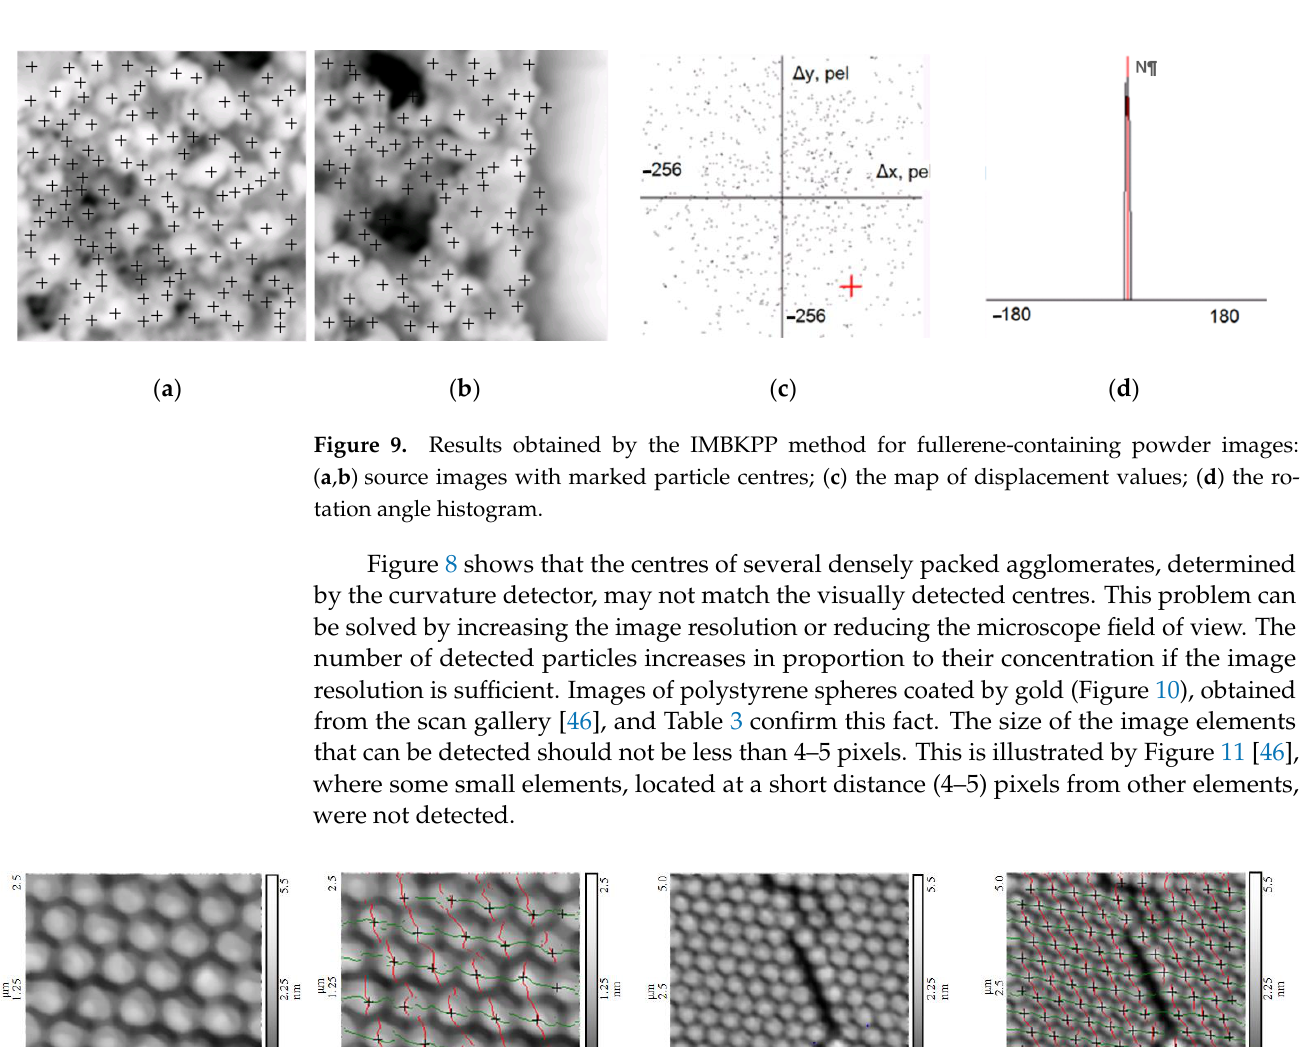
Figure 8. Results obtained by the IMBKPP method for the copper microparticles’ images: ( a , b ) source images with marked particle centres; ( c ) the map of displacement values; ( d ) the histogram of rotation angles.